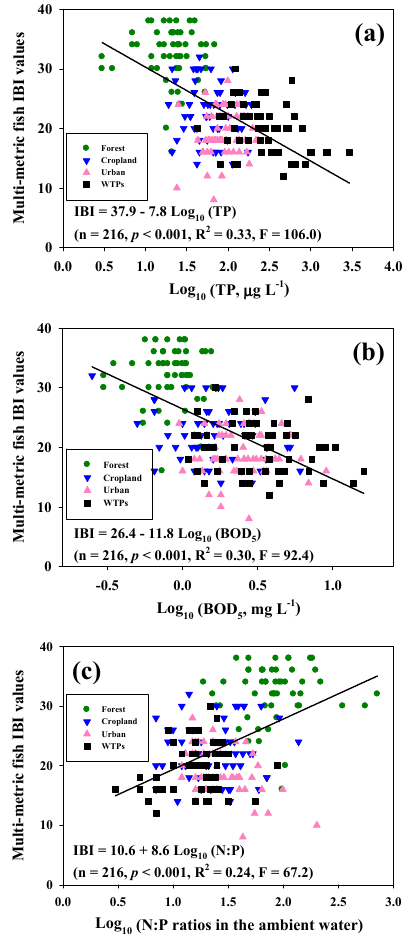
Figure 5. Relationships between multi-metric fish index of biological integrity (IBI) values and log 10 -transformed ( a ) TP; ( b ) BOD 5 ; ( c ) N:P ratios in the ambient water.